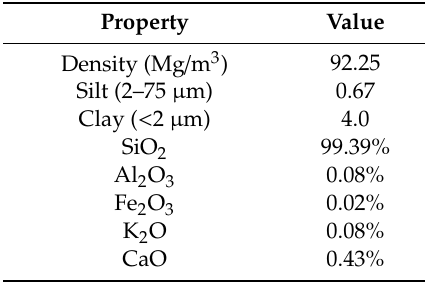
Table 3. Properties of silica fume